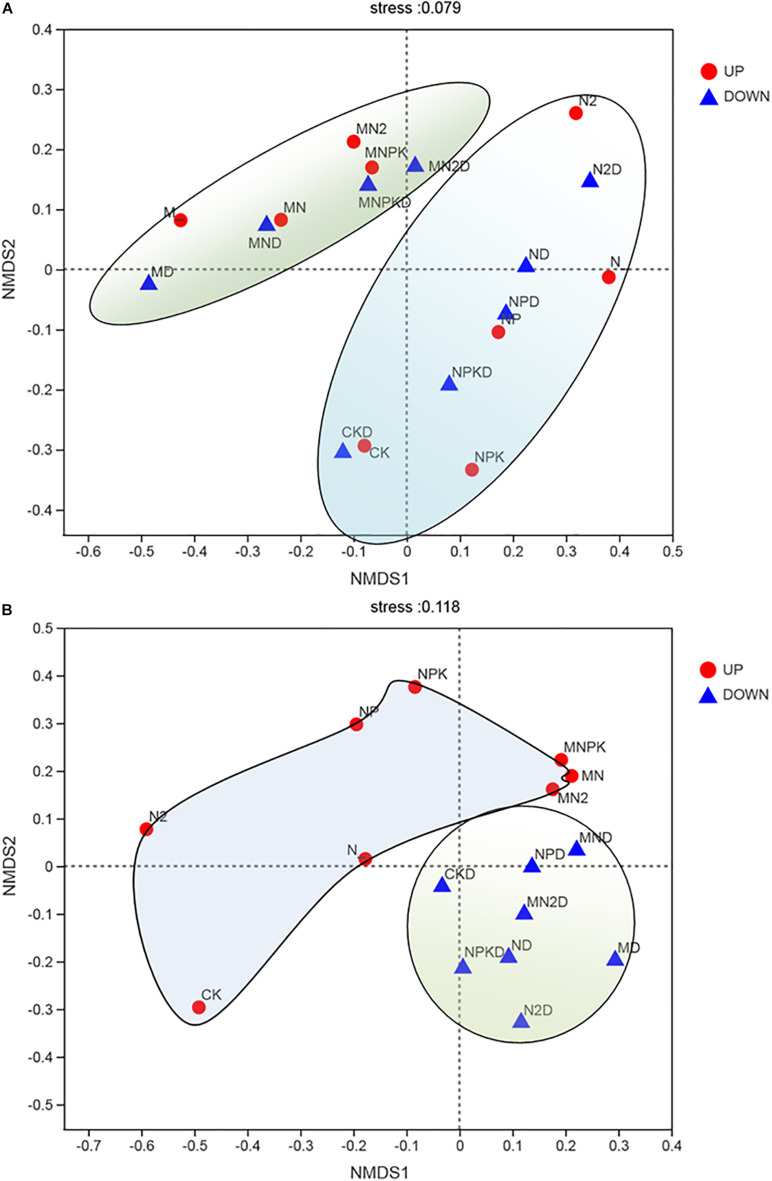
Non-metric multidimensional scaling (NMDS) of AOA (A) and AOB (B) in two soil layers under different fertilization treatments. UP represented surface arable soil (0–20 cm) and Down represented plow pan soil (20–40 cm). Points of different colors or shapes represent samples of different groups. The closer the two sample points are, the more similar the species composition of the two samples. The abscissa and ordinate indicate the relative distance and have no practical meaning. Stress: Test the pros and cons of NMDS analysis results. It is generally believed that when stress is less than 0.2, it can be represented by a two-dimensional dot diagram of NMDS, which has a certain explanatory meaning; when stress is less than 0.1, it can be considered as a good ranking.